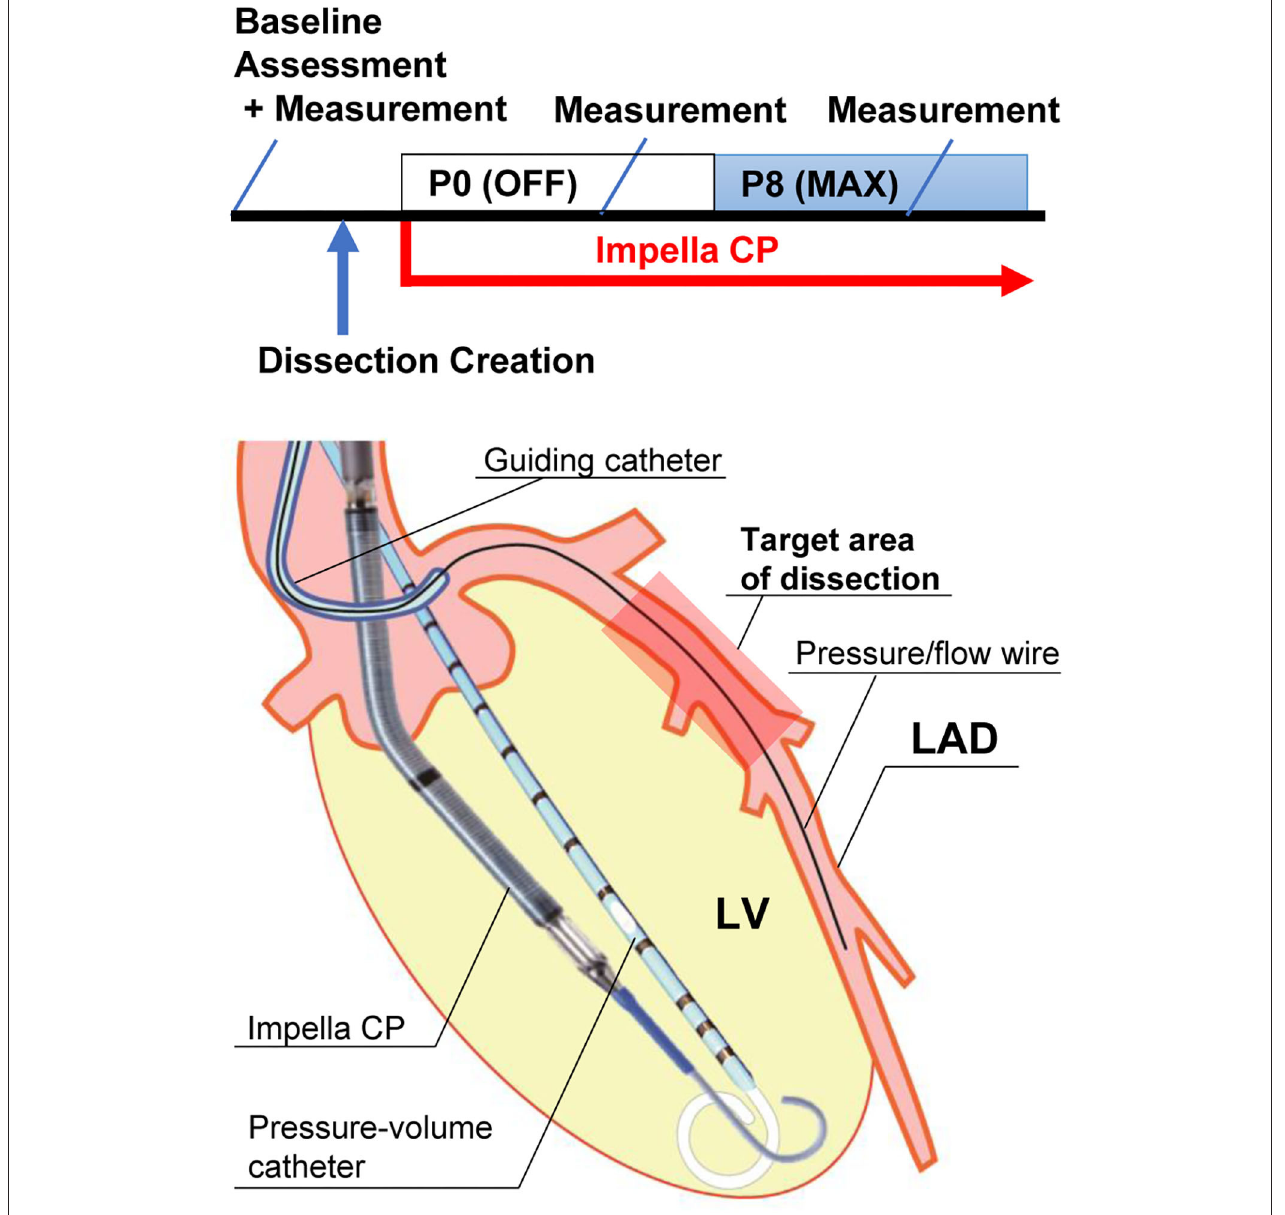
FIGURE 1 | Experimental protocol and illustration of equipment. The upper panel shows the experimental protocol. “Baseline assessment” includes echocardiogram and pressure measurement. “Measurement” includes pressure–volume measurement, coronary pressure/flow, and coronary angiogram. The lower panel shows an illustration of the equipment. An Impella CP and a pressure–volume catheter are in the left ventricle (LV). A pressure/flow wire is placed in the mid-left anterior descending artery (LAD) distal to the dissection. The wire was aligned parallel to the LAD lumen for accurate measurement. Impella CP provided 2.3–3.0 L/min of flow from the LV to the aorta at P8 maximal (Max)